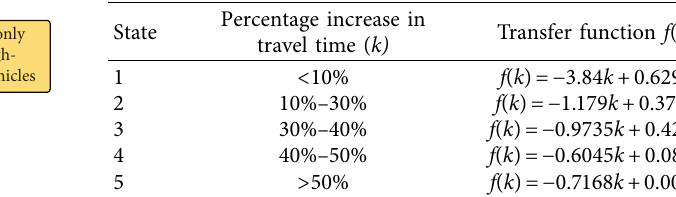
Figure 5: Flow chart of HOV dynamic control process.